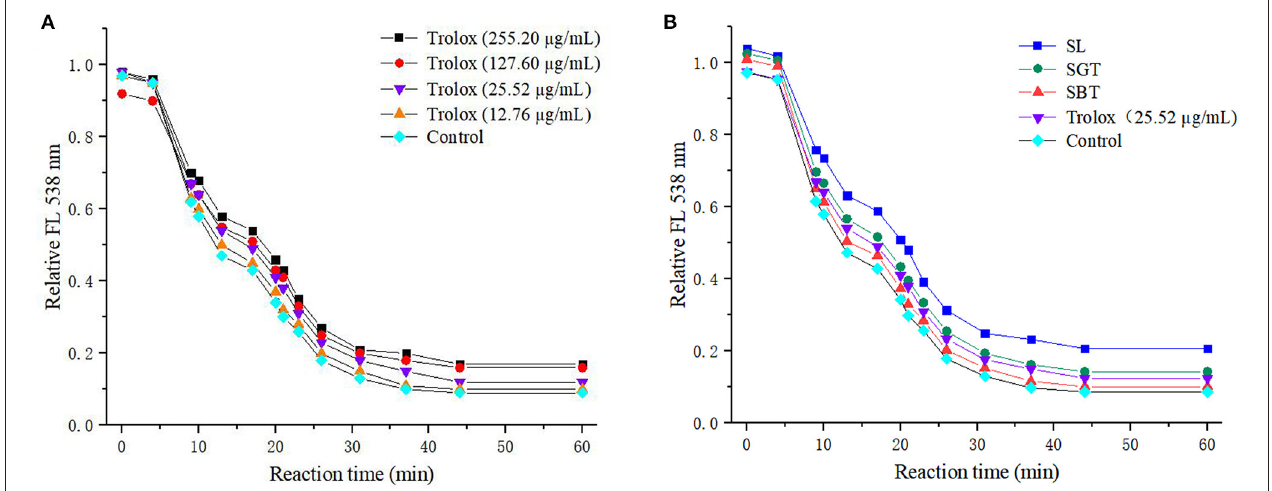
FIGURE 8 | Fluorescence decay curves induced by AAPH in the presence of Trolox (A) and sea buckthorn leaves tea (B)